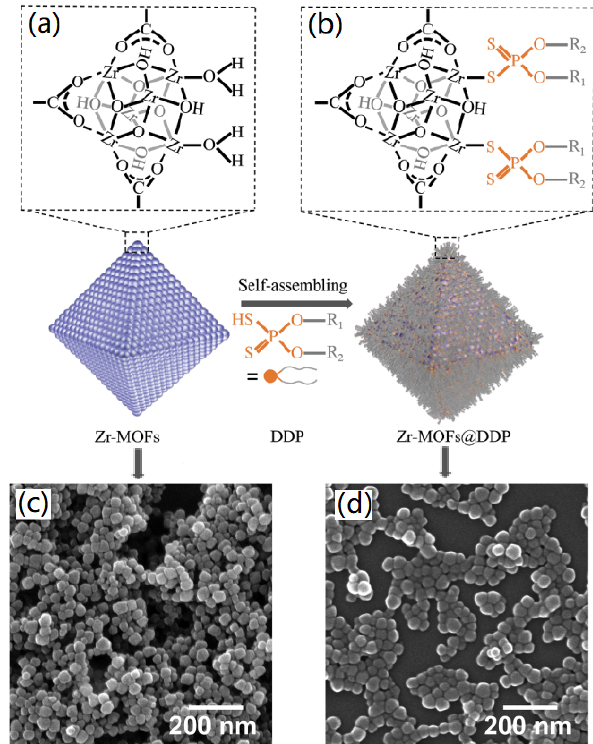
Fig. 7 Schematic illustration for surface functionalization of Zr-MOFs@DDP. Chemical structures and scanning electron microscopy (SEM) images of Zr-MOFs and Zr-MOFs@DDP were shown in (a, b) and (c, d), respectively. Reproduced with permission from Ref. [113], © Elsevier B.V.